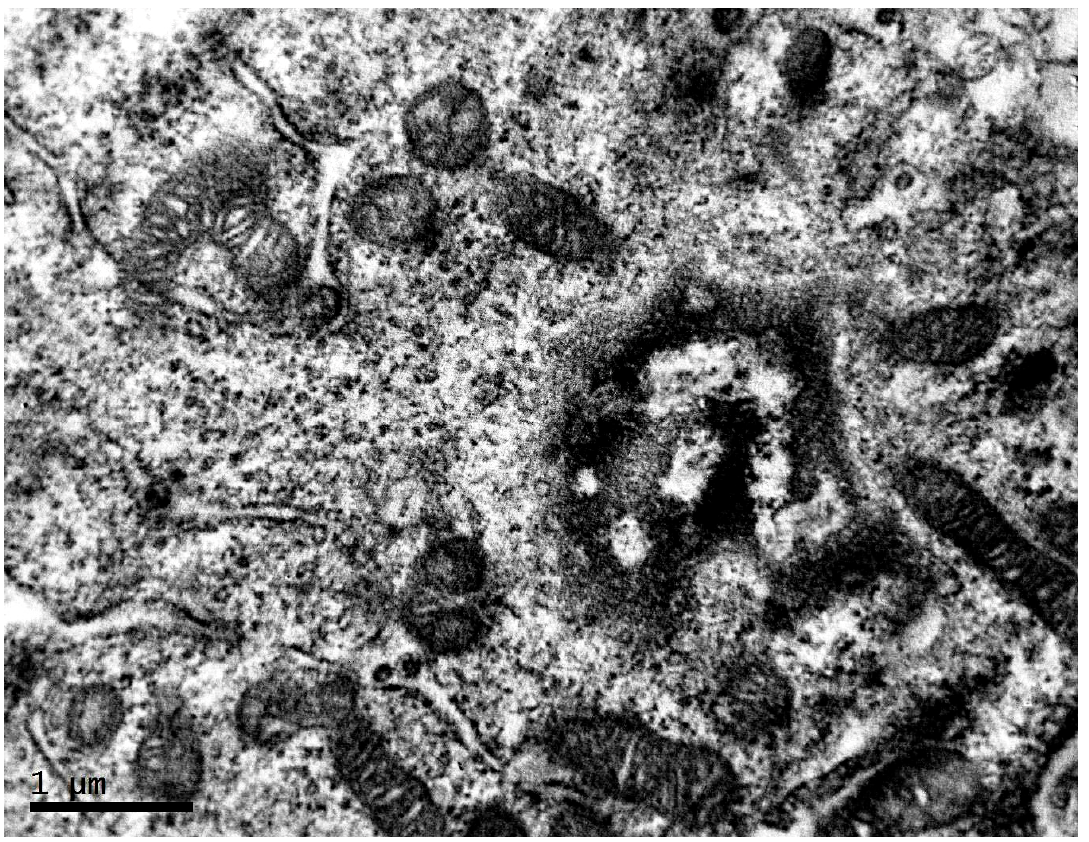
Figure 8. Organelles of cells of transplantable malignant melanoma B16 under the influence of constant lighting. TEM, ×20,000.